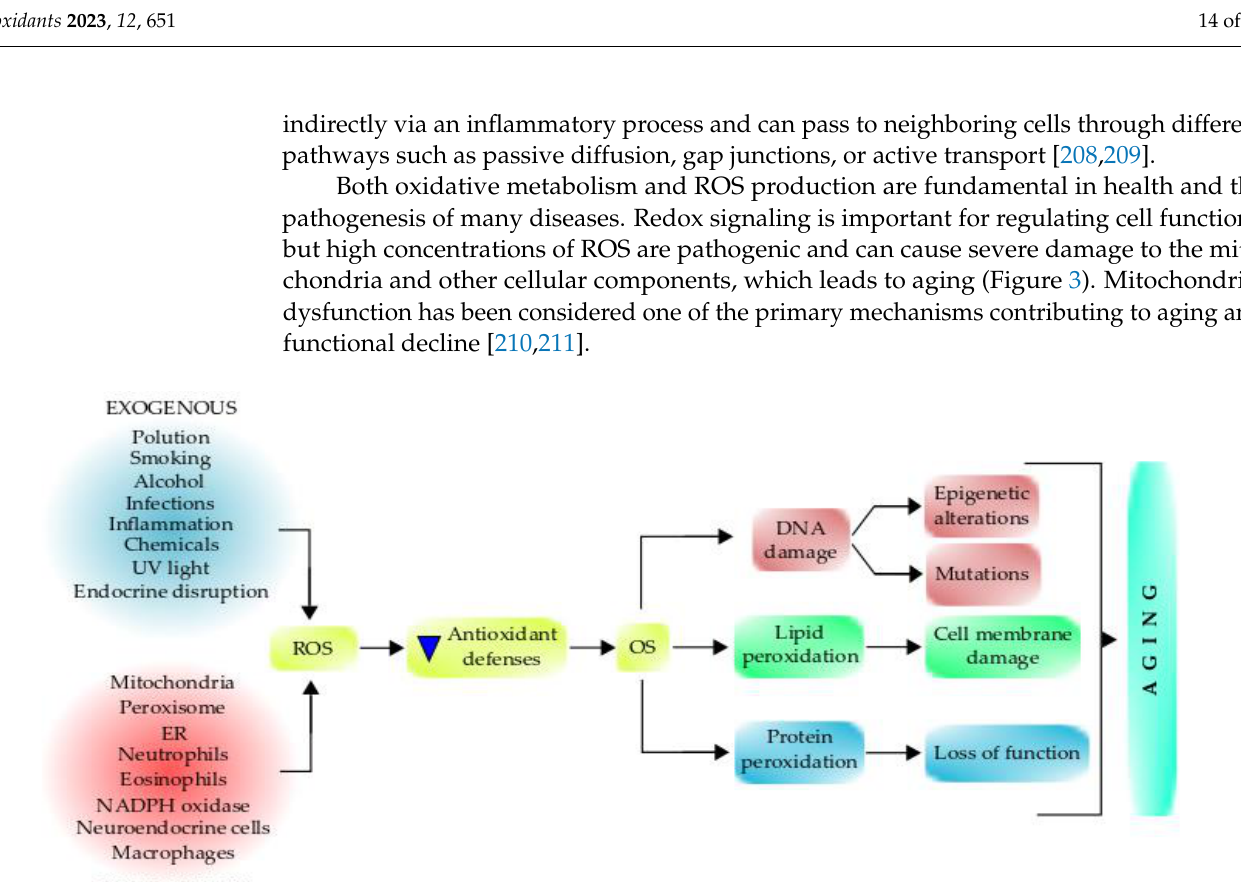
Figure 3. Role of free radicals on oxidative stress and the aging process. Various endogenous and exogenous factors can generate free radicals/oxidants, affecting the antioxidant defenses, which promote oxidative stress that can damage different biomolecules. The damaged biomolecules affect inter and intracellular signaling and gene expression pathways, causing several cell alterations. The interplay between these events can lead to aging, which increases aging-associated syndromes and aging-related diseases. Antioxidant supplementation can retard the aging process.